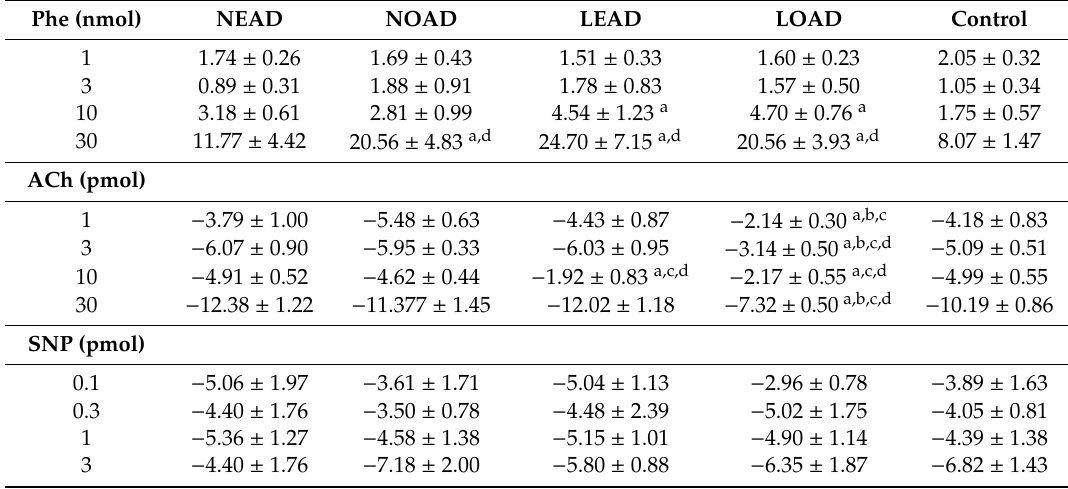
Table 5. Mesenteric vascular bed reactivity in the various groups over 60 days of treatment. The data are presented as perfusion pressure variation (mmHg) after Phe, ACh, and SNP administration. Phe (nmol) NEAD NOAD LEAD